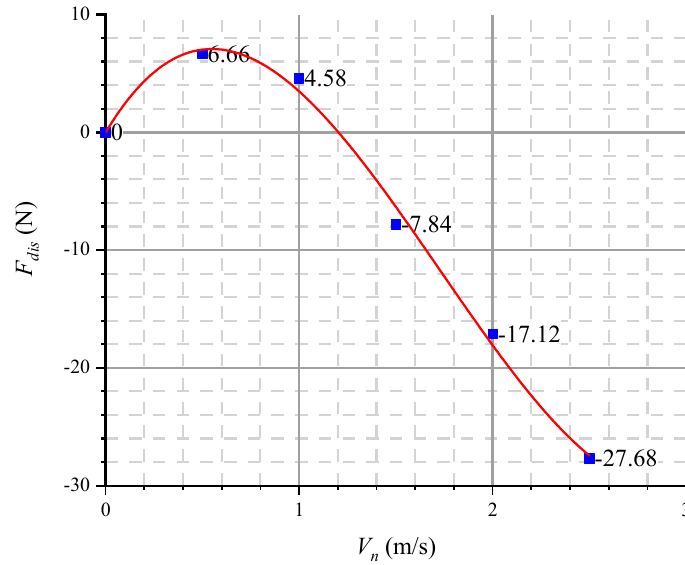
Figure 24. Fitting curve of the relationship between F dis and V n.